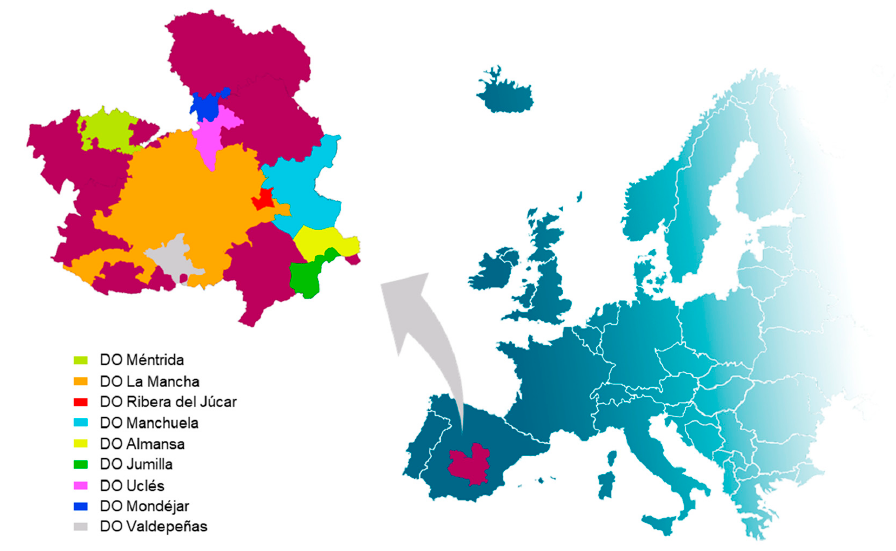
Figure 1. Wine designations of origin (DOs) in the Spanish region of Castilla-La Mancha.